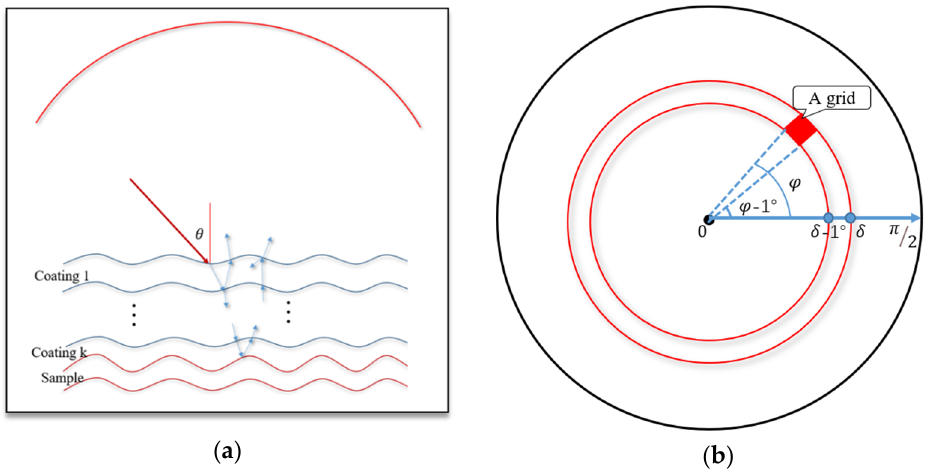
Figure 2. ( a ). Model of sample covered by coating layers, ( b ) the top view of the upper hemi ‐ sphere.